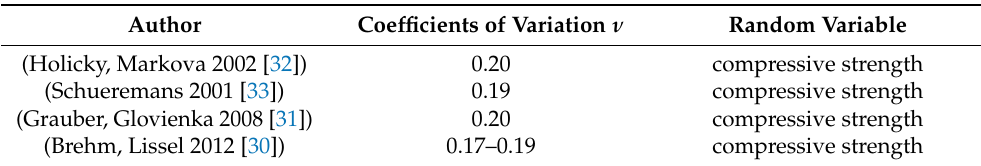
Table 5. Coefficients of variation of compressive strength of various types of masonry estimated in the literature.